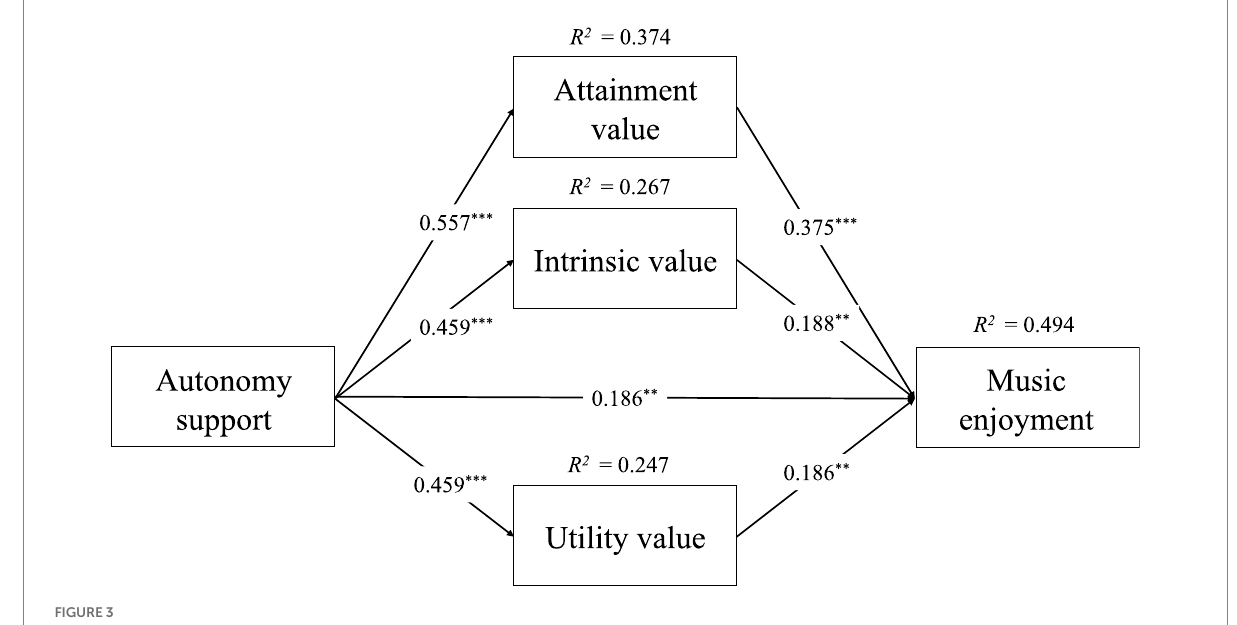
FIGURE 3 Mediation model of music values between autonomy support and music